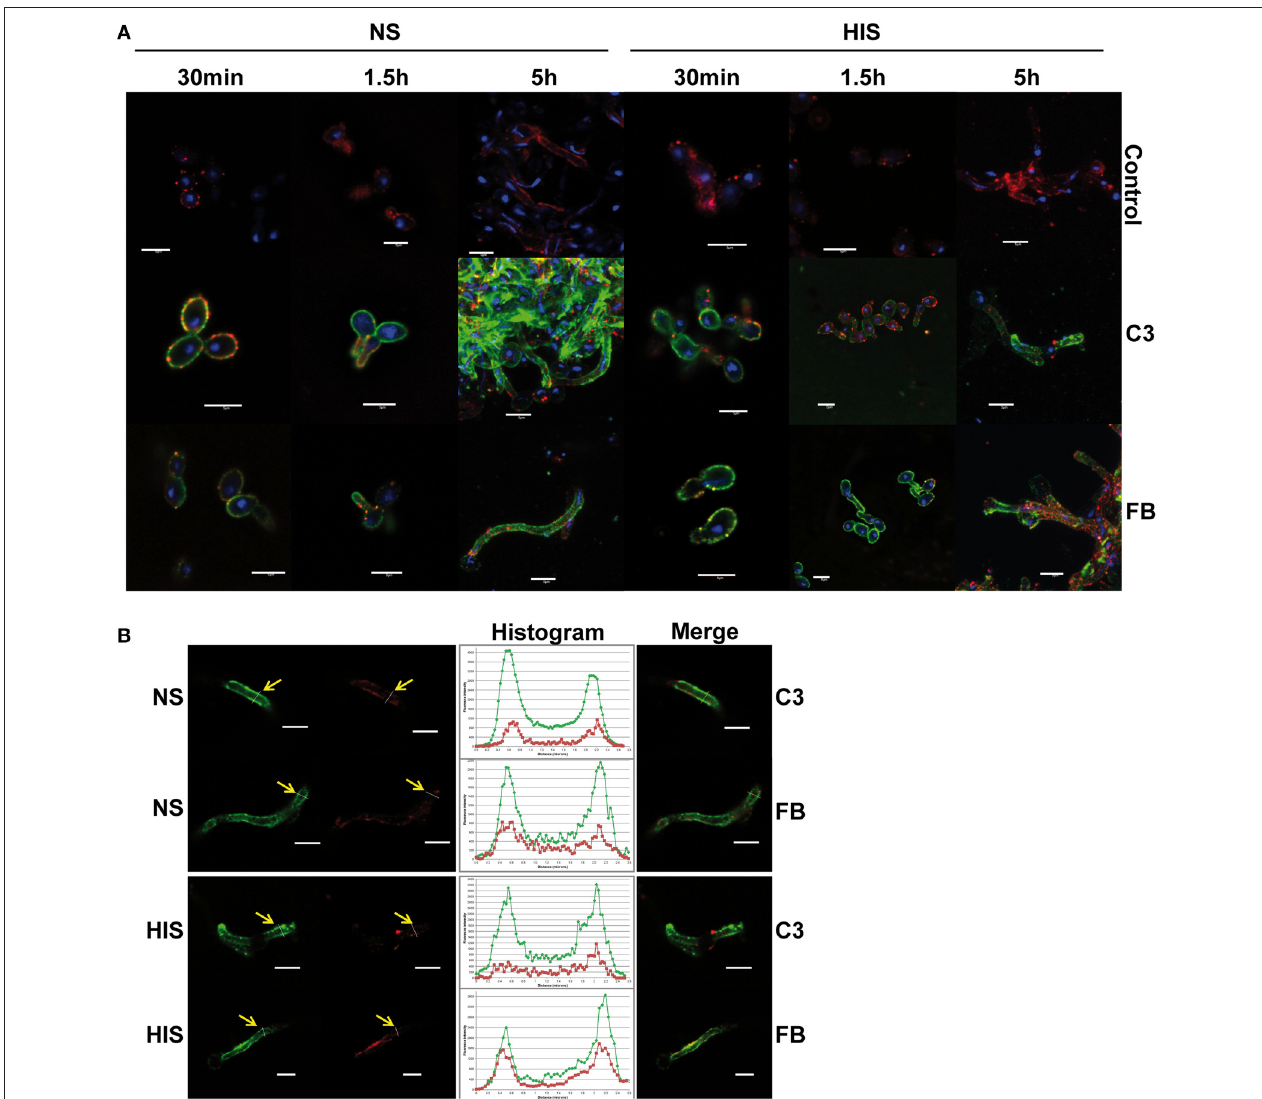
FIGURE 3 | Detection of C3 and factor B on C. albicans surface after incubation with human serum. (A) Immunofluorescence assay to detect C3 and factor B (FB) on C. albicans surface incubated 30min, 1.5 and 5h with normal serum (NS; left panels) or heat inactivated serum (HIS; right panels). Control images showed the background of secondary antibody (anti-rabbit-A488). (B) Co-localization of C3 and FB with C. albicans plasmatic membrane (staining with PKH26) was examined by the analysis of confocal microscopy images, after 5h of incubation with NS and HIS. Representative images are shown. Yellow arrows indicate position of transversal sections of illustrative histograms. Co-localization analysis was performed using FiJi software. Red staining of plasmatic membrane was done with PKH26, blue staining of DNA with DAPI and green staining with anti-rabbit-A488. Line in bottom right corner indicated in all figures corresponds to a 5 µ